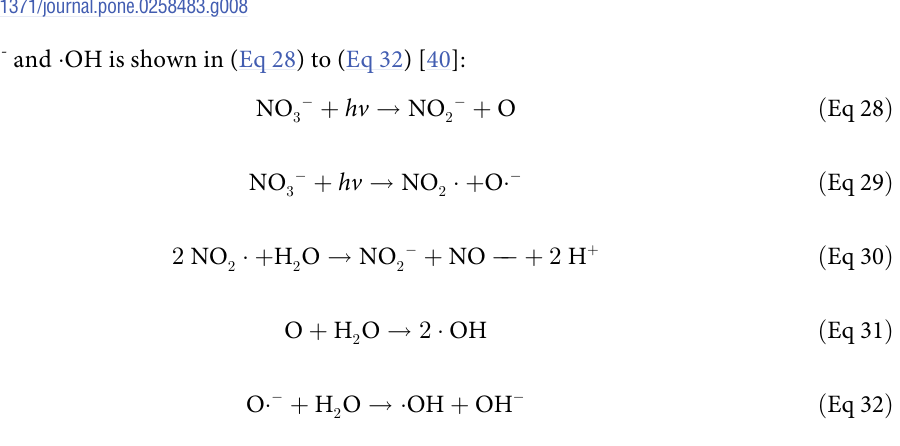
Fig 8. Effect of NO 3- on the removal rate (a), kinetics constant (b) and linear fitting between kinetics constant and concentration of NO 3- on the degradation of NIF via UV/H 2 O 2 . The error bars represent the standard deviation (n = 3).